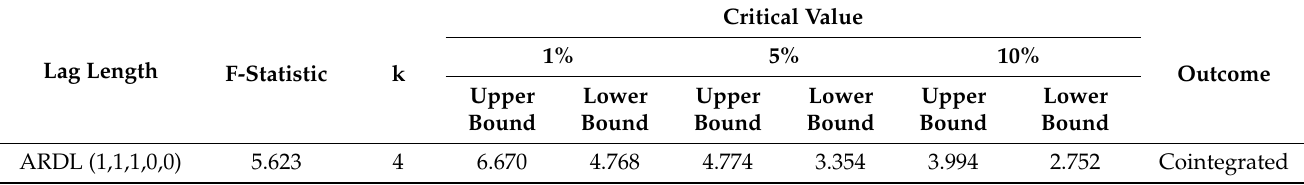
Table 6. Bounds test